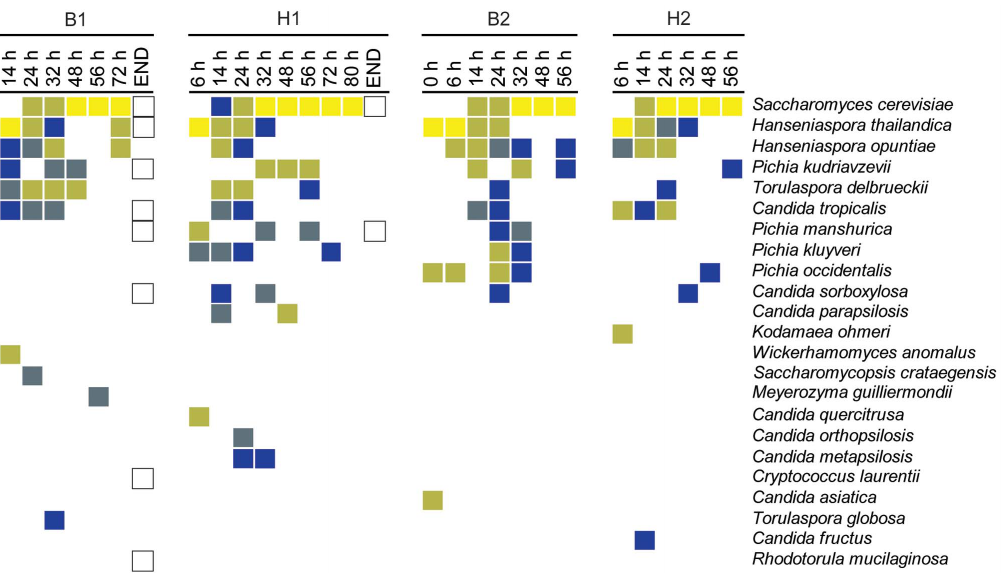
Figure 2. Yeast diversity in four Malaysian spontaneous cocoa pulp fermentations. Box fermentation 1 (B1, October 2011), heap fermentation 1 (H1, October 2011), box fermentation 2 (B2, January 2012) and heap fermentation 2 (H2, January 2012). In total, 769 yeast isolates were identified, allowing an in-depth analysis of the yeast diversity. Yeast species are ordered according to the frequency by which they were isolated from the different fermentation samples. The upper eight species were found in at least three fermentations, while the other species were only found in two or less fermentations. When the yeast counts were above the detection limit, different colors represent the relative population size of a certain species at a certain time point (dark blue : , 5%, light blue : 5–10%, dark yellow : 10–50%, yellow : 50–100%). Hollow squares indicate that the yeast species was detected when the yeast cell count had dropped below the detection limit.